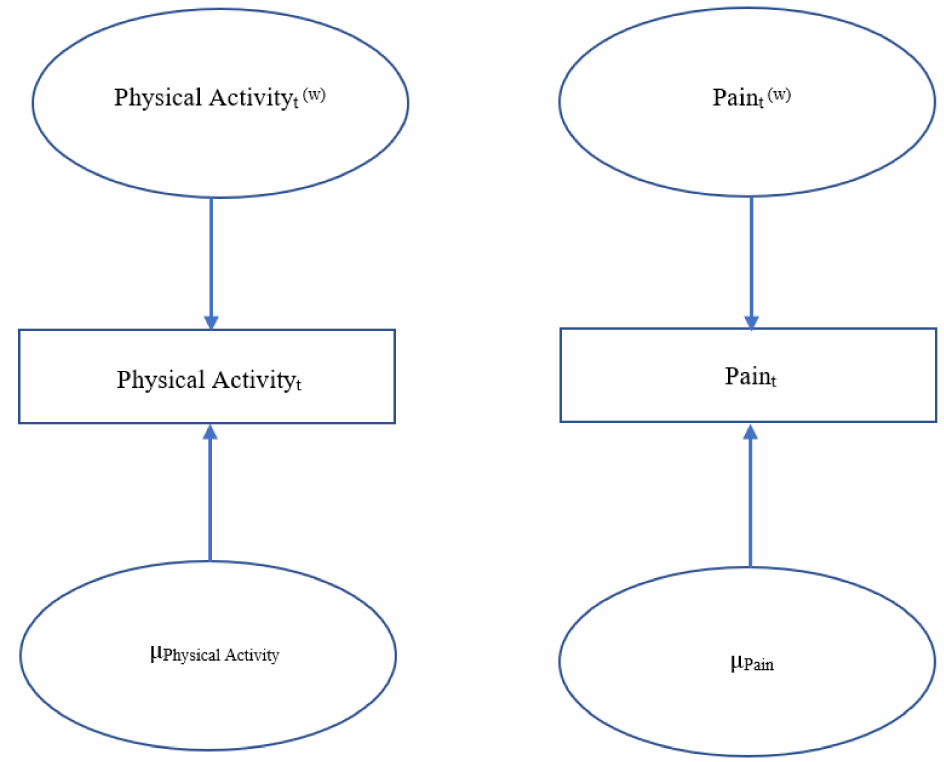
Figure 1. VAR(1) Model: Decomposition. Note. Figure 1 depicts the decomposition of the study data into within- and between-person components. T represents time point, w represents within-person, and µ represents between-person